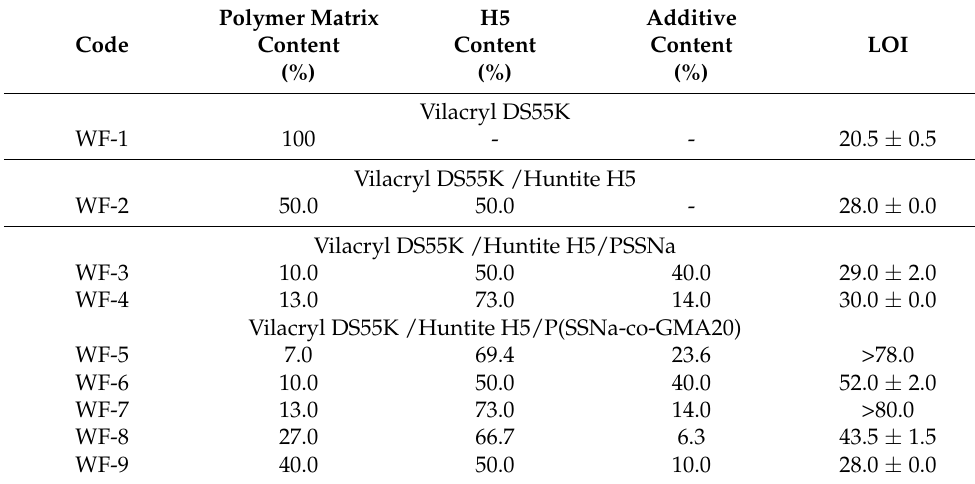
Table 1. Film quality and LOI results for coatings based on Vilacryl DS55K, H5 and ROs.